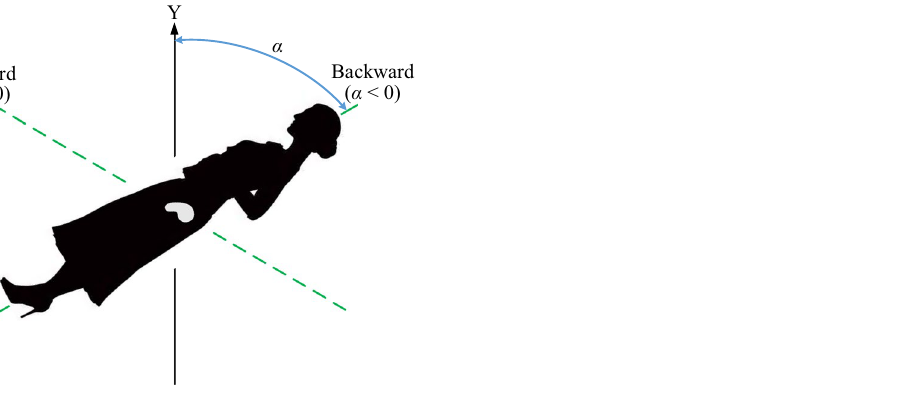
Figure 3. Body tilt angle diagram with different